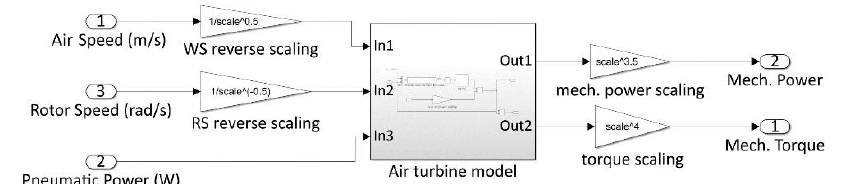
Figure 7. Simulink model of air turbine using the torque and the input coefficients.